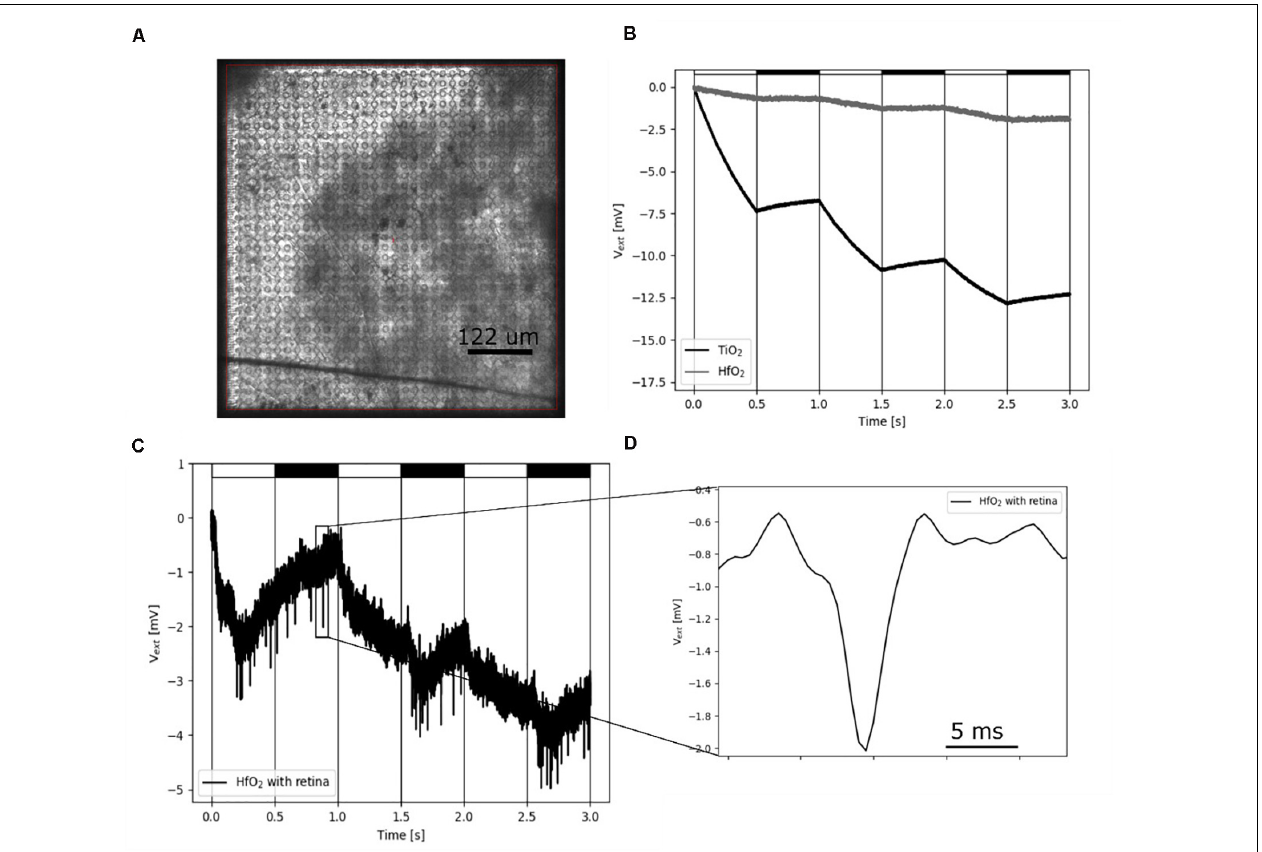
FIGURE 5 | Recording of electrical single-cell activity using hafnium oxide-coated CMOS MEA. (A) Photograph of the CMOS sensor array with interfaced retina. (B) Light-induced drift by illumination using a 460-nm LED on sputtered TiO 2 and low-temperature HfO 2 ALD-coated CMOS-MEAs. The LED is pulsed with a cycle of 1-Hz, on-off periods represented by white and black rectangles. (C) Low-pass filtered (1.5 kHz) HfO 2 ALD-coated CMOS MEA sensor signal. The sensor signal shows spikes of a retinal ganglion cells upon stimulation with 460-nm 1-Hz flicker. (D) Zoom of one single extracellular retinal action potential from panel (C)